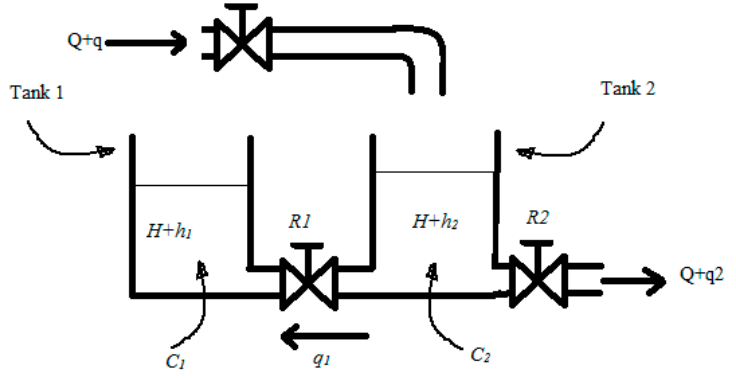
Figure 7. Two tank liquid-level system [4].